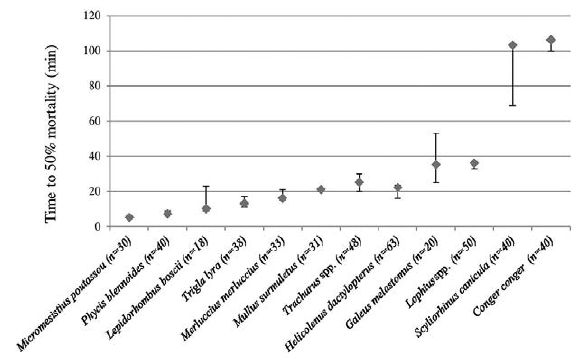
Fig. 4 – Time to 50% mortality for the species included in the analy- sis. Error bars represent 95% confidence intervals.